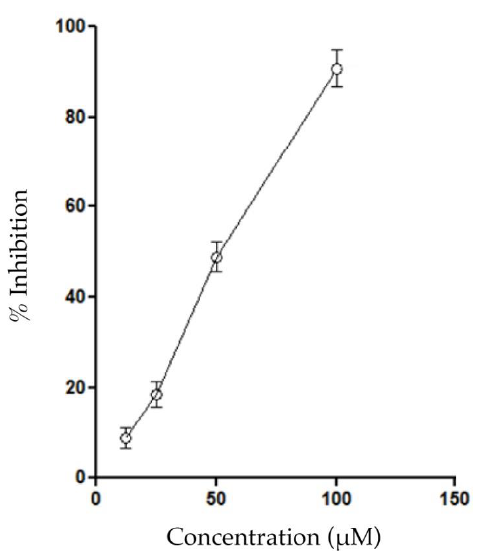
ff erent concentrations were